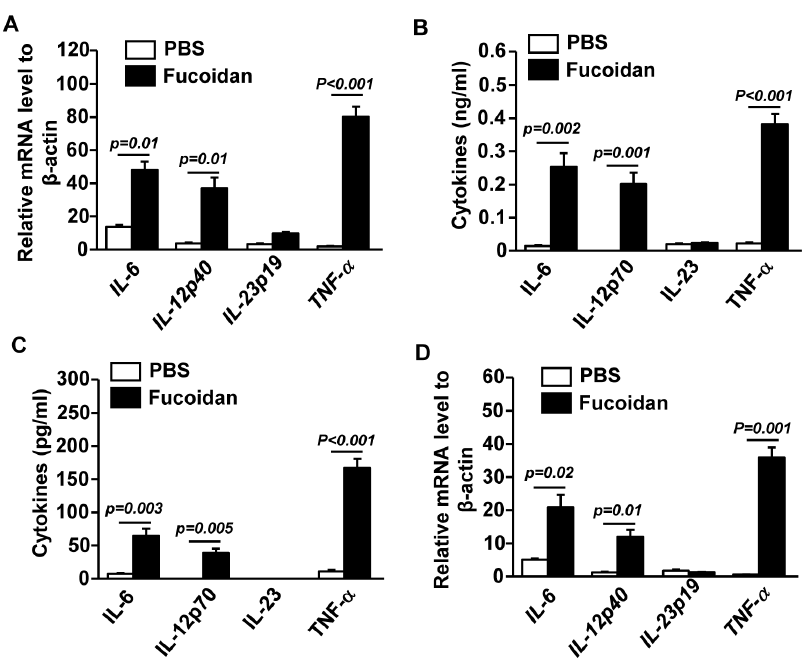
Figure 2. Fucoidan promotes production of pro-inflammation cytokines in cDCs. Expression levels of IL-6, IL-12p40, IL-23p19 and TNF- a mRNA in spleens were measured 3 hrs after fucoidan injection. (A) mRNA levels of IL-6, IL-12p40, IL-23p19 and TNF- a in spleens. (B) IL-6, IL-12p70, IL- 23 and TNF- a concentration in serum. (C) Lineage 2 CD11c + cDCs were isolated by cell sorter 2 hrs after fucoidan injection. Isolated cDCs were incubated in culture medium for 4 hrs, and then analyzed for IL-6, IL-12p70, IL-23 and TNF- a levels in the culture supernatants were measured by ELISA. (D) mRNA levels of IL-6, IL-12p40, IL-23p19 and TNF- a from isolated cDCs. All data are representative of or the average of analyses of 6 independent samples (2 mice per experiment, total 3 independent experiments).